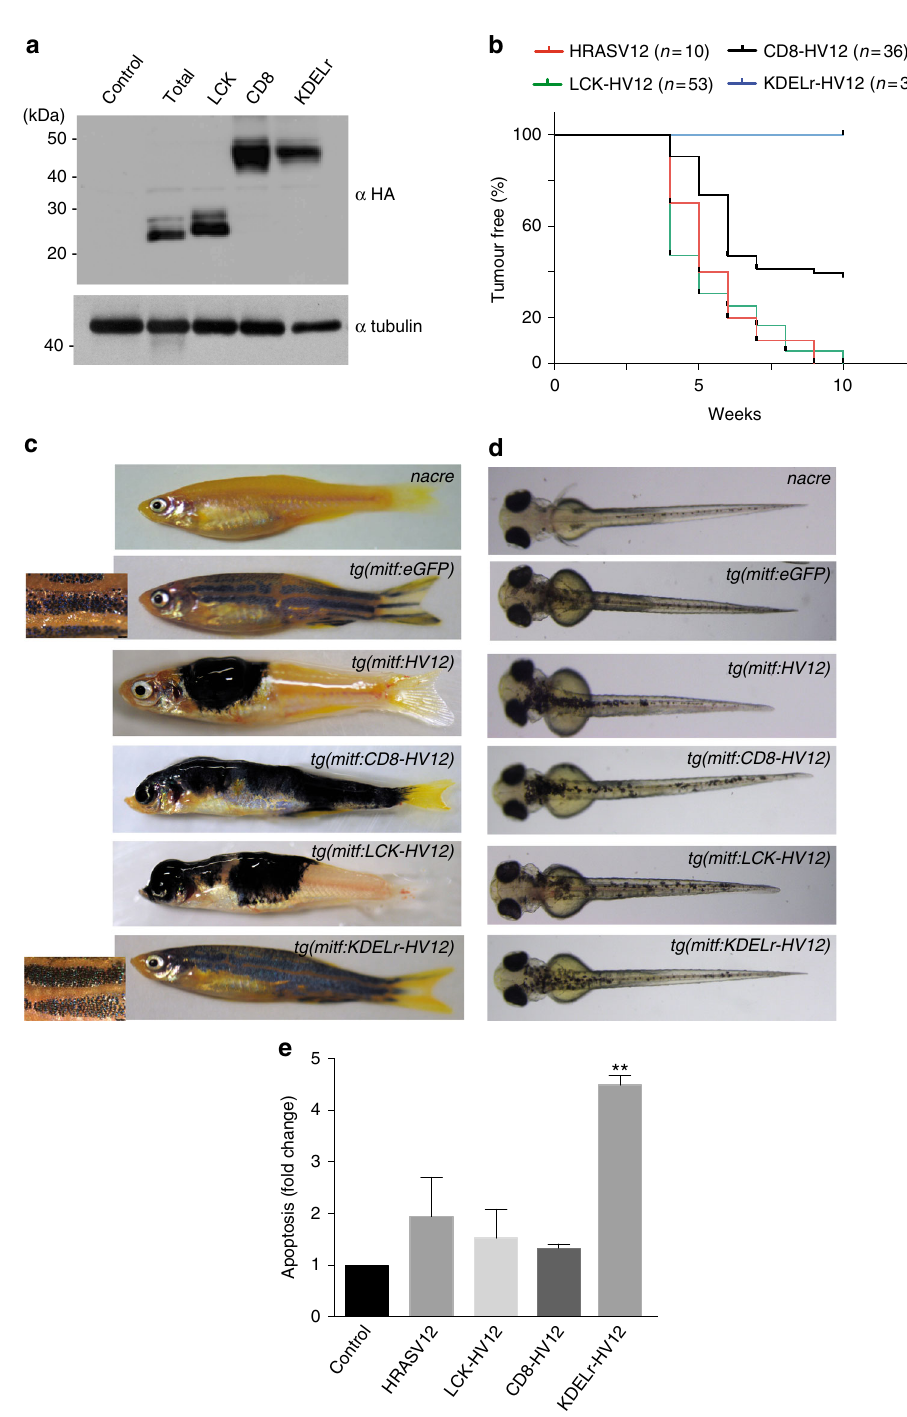
Fig. 8 Oncogenic effects of activated RAS at the GC. a Expression of the indicated constructs transfected (1 μ g) in CHL melanocytes. b Kaplan – Meier plot of the Incidence of melanoma by 10 weeks post fertilization in nacre zebra fi sh expressing the indicated HRASV12 site-speci fi c transgenes using the miniCoopR system. c Representative images of adult zebra fi sh expressing the indicated HRASV12 site-speci fi c transgenes at 8 weeks post fertilization compared to nacre. Insets are magni fi cation of stripes. d Representative images of zebra fi sh embryos expressing the indicated HRASV12 site-speci fi c transgenes at 3 days post fertilization compared to uninjected nacre. e Apoptosis induction by the indicated HRASV12 site-speci fi c constructs in CHL melanoma cells. Results, relative to the values found in vector-transfected cells, show average ± SEM from three independent experiments ** p < 0.01 by Student's t -test. See also Supplementary Fig.